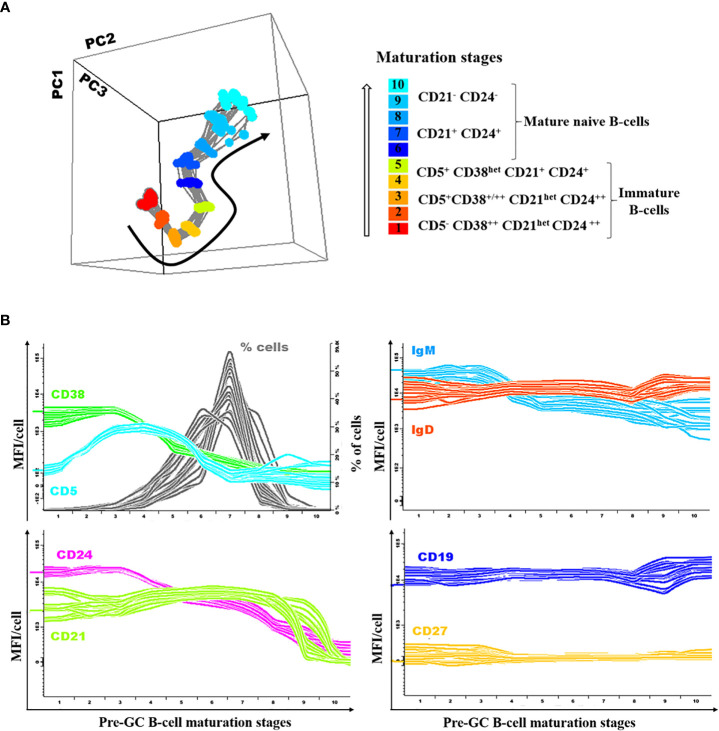
Illustrating example of the normal (reference) pre-germinal-center (GC) maturation pathway. Overall phenotypes (A) and expression levels for individual markers per stage of maturation (B) are shown for each individual donor (n=18) included in the normal reference pre-GC B-cell maturation pathway used to define reference normal values, depicted as color-coded lines per marker/parameter.